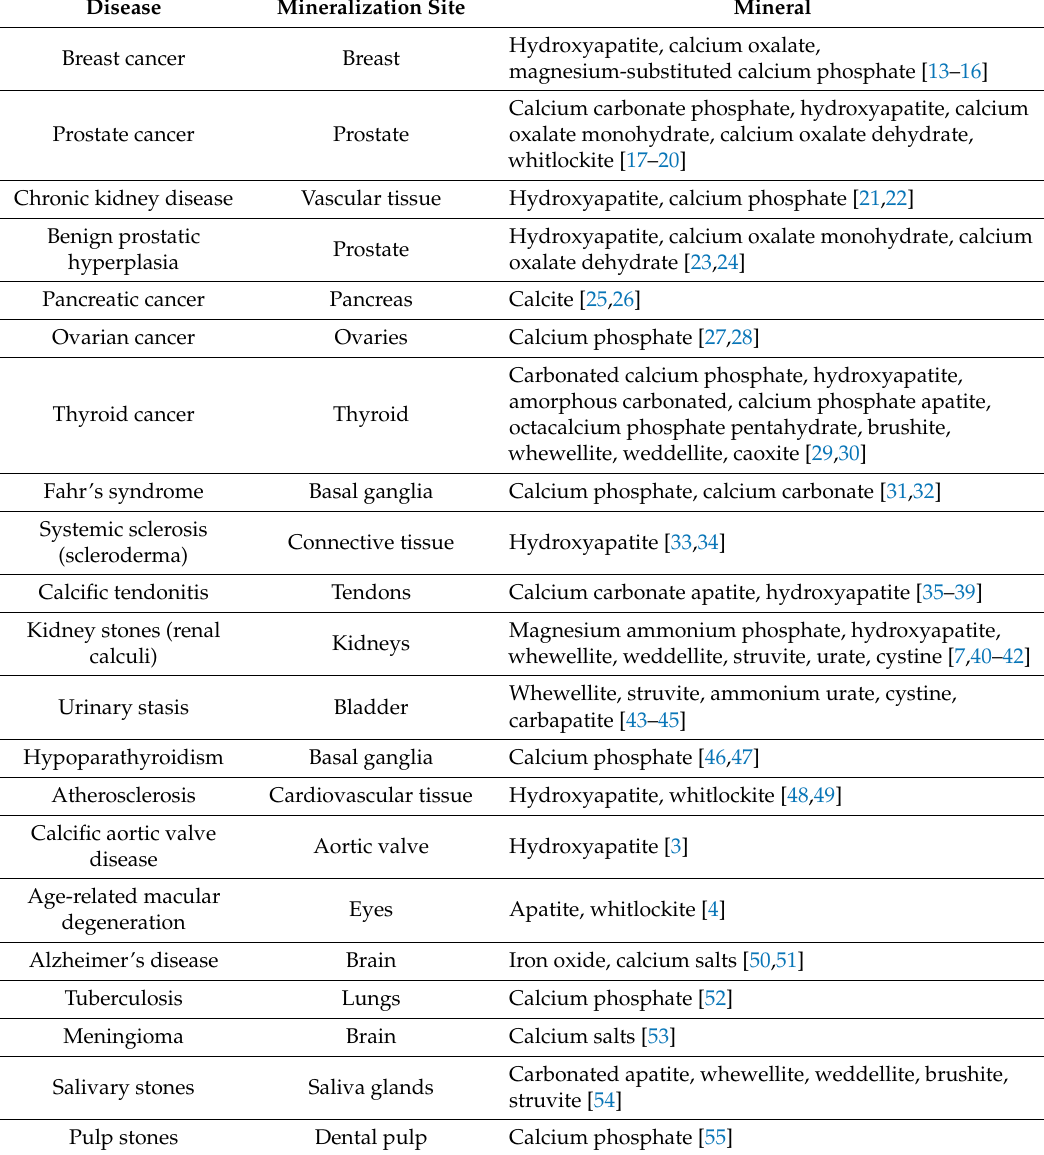
Table 1. List of main diseases associated with pathological mineralization along with information on the a ff ected tissues and chemical composition of the observed minerals. Note: Hydroxyapatite is used in this table for consistency with the literature. We acknowledge, however, that the best word would have been apatite, which can be surrounded by anions other than OH −